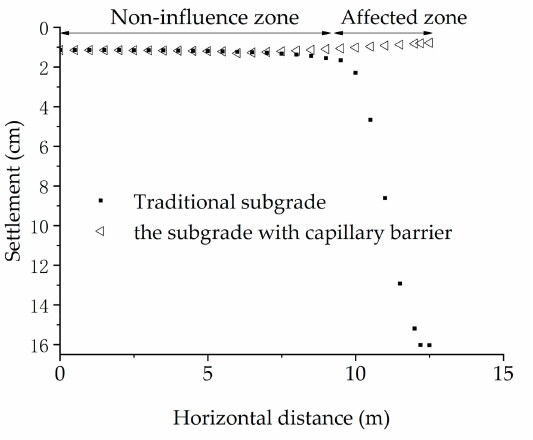
Figure 9. Comparison of the settlement in the different